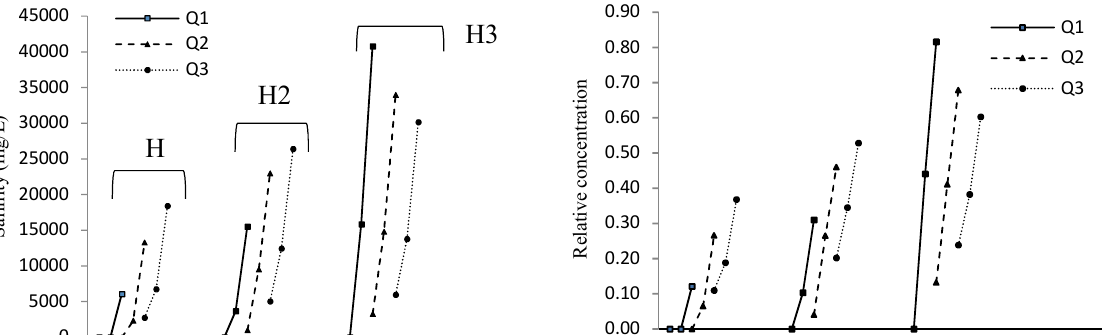
Fig. 6: Comparing the combined effects of the factors on the final salinity of the extracted water (each group of lines indicate the H, the line type indicates the Q and the points on every line indicate the Cs)